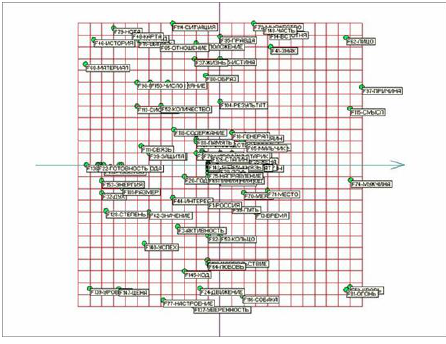
Figure 2. Extension of the elastic map for the transposed